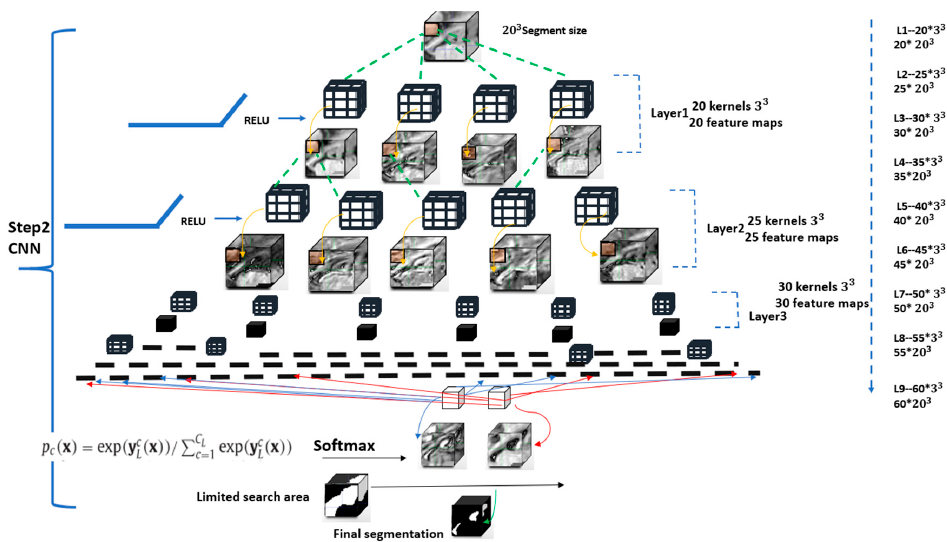
Figure 2. Three sagittal MRI bounding boxes and hippocampal ROIs (green), corresponding to three different patients. The ROI includes the hippocampus, and part of the white matter, Cerebro Spinal Fluid (CSF), and amygdala.